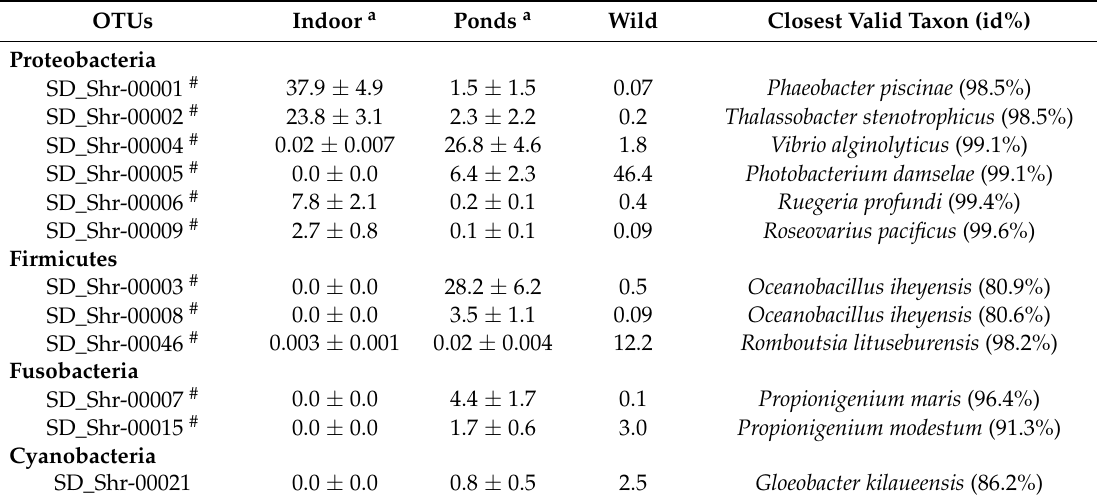
Table 5. Relative abundance (%) of main Operational Taxonomic Units (OTUs) in the intestinal tract of whiteleg shrimp raised under two different production systems and from a wild population. OTUs Indoor a Ponds a Wild Closest Valid Taxon